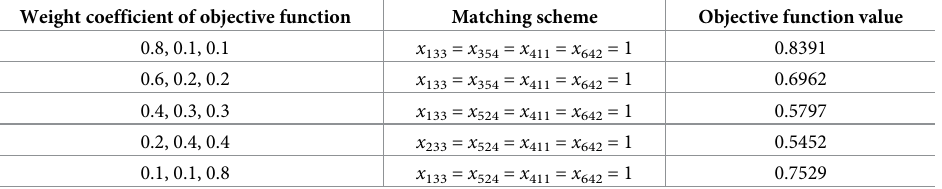
Table 6. Parameter analysis of the weight of the objective function.